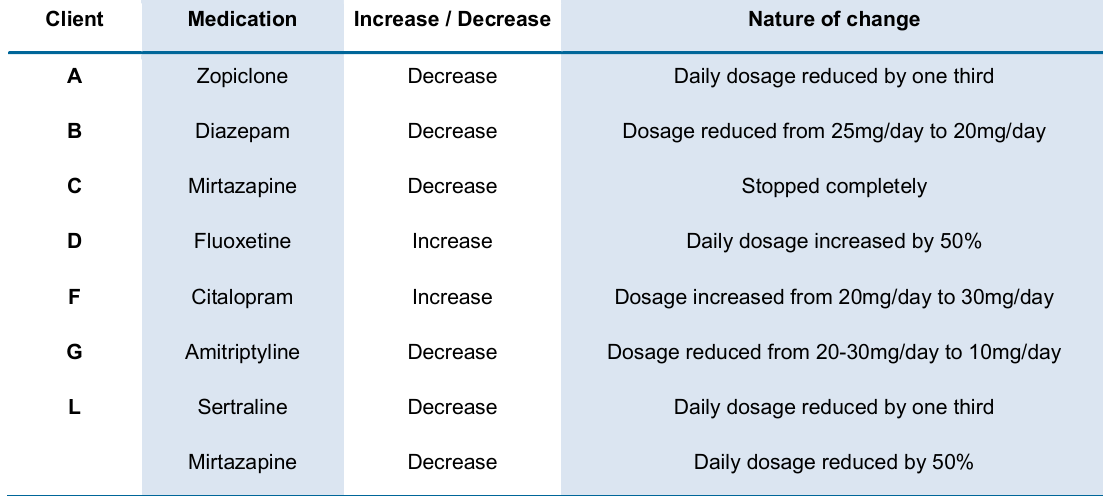
Table 14: Changes in Psychiatric Medication during TA Psychotherapy